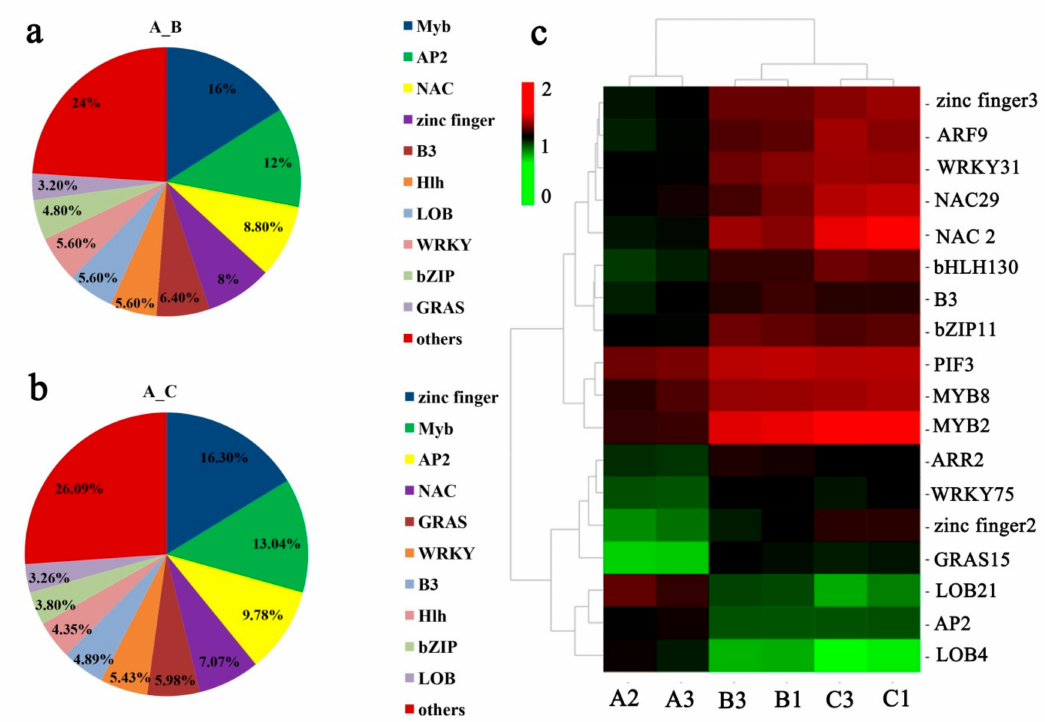
Figure 4. Analyses of the transcription factors (TFs) involved in Camellia oleifera ‘Huaxin’ response to low-temperature stress. ( a ) Distribution of transcription factor families in the A_B gene set; ( b ) Distribution of transcription factor families in the A_C gene set; ( c ) Expression profiles of 18 di ff erentially expressed TFs among di ff erent samples. The heat map was generated from the log10 (FPKM values). Changes in expression level are represented by a change in color; green indicates a lower expression level, whereas red indicates a higher expression level. FPKM: fragments per kilobase of transcript per million mapped reads